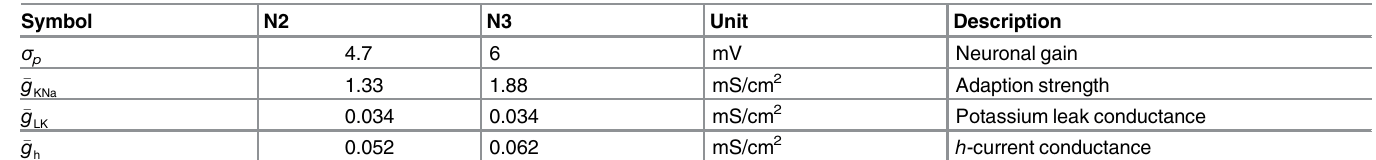
K-complexes and spindles during sleep stage N2 In the coupled system, the cortex provides excitatory drive to the thalamic module, since it is predominantly in the active state. In order for the thalamic module to exhibit rhythmically and (cid:2) g slightly to account for that additional occurring spindle oscillations we had to adjust (cid:2) g h LK depolarization (see Table 2). We choose the right spindle regime, as it was suitable for repro- duction of both sleep stage N2 and N3. As can be seen in Fig 4 spindles may be triggered by KCs in the full model, but may also occur independent of KCs. During a KC the sudden drop of excitatory drive hyperpolarizes the . The ensuing depolarization upon the RE and TC population, leading to deinactivation of I T transition back to the active state triggers a LTS and a spindle sequence in turn. The spindle then projects back into the depolarizing phase of the KC. This is in good agreement with the grouping of spindles and KCs observed experimentally [6, 74]. Although less likely the model can also give rise to KCs triggered by a spindle. This can be achieved by increasing the connection strength from the thalamic to the cortical module (model output not shown). During N2, KCs occur at a low rate. Hence, spindle initiation and (Fig 3A), similar to the isolated thalamic termination are closely linked to the time course of I h module. The parameters for the output in Fig 4 are given in Table 2. Table 2. TC parameter settings.